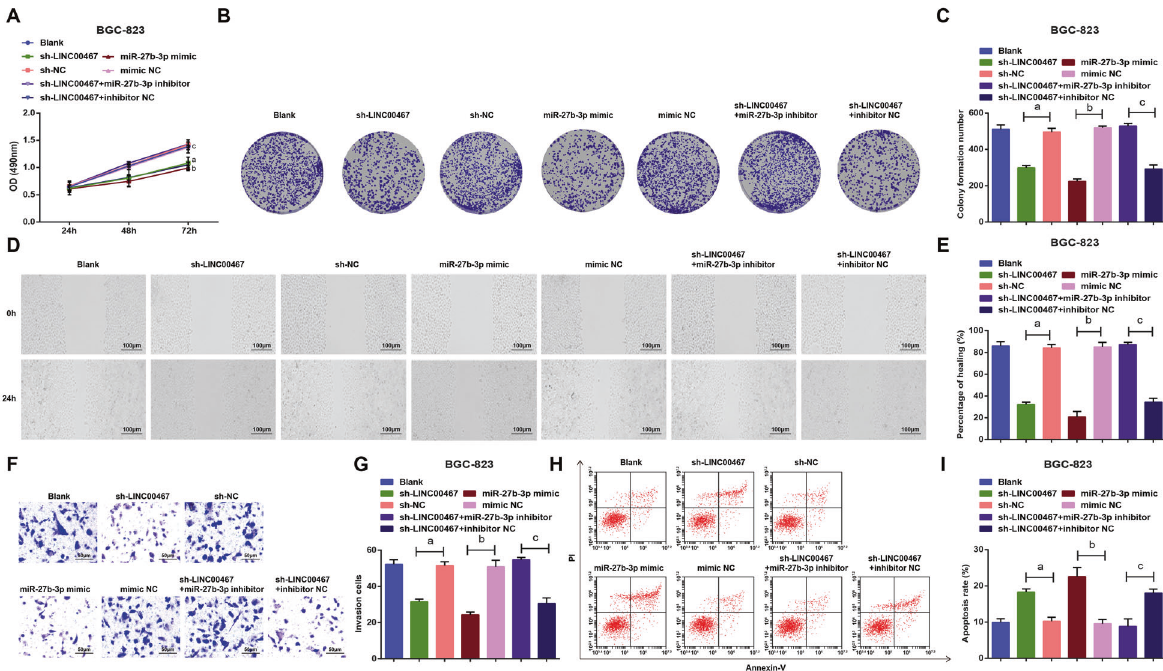
Fig. 3 Knockdown of LINC00467 or elevation of miR-27b-3p suppresses malignant behaviors of GC cells. A BGC-823 cell growth was measured by MTS colorimetry. B Colony formation ability of BGC-823 cells was detected by colony formation assay. C Number of colonies of BGC-823 cells. D Migration ability of BGC-823 cells was measured by scratch test. E Comparison of healing rate of BGC-823 cells among the groups. F Invasion ability of BGC-823 cells was measured by Transwell assay. G Comparison of invasive ability of BGC-823 cells among the groups. H Apoptosis rate of BGC-823 cells in each group. I Apoptosis of BGC-823 cells was gauged by fl ow cytometry; a P < 0.05 vs the sh-NC group, b P < 0.05 vs the mimic NC group, c P < 0.05 vs the sh-LINC00467 + inhibitor NC group; N = 3; the measurement data were expressed as mean ± standard